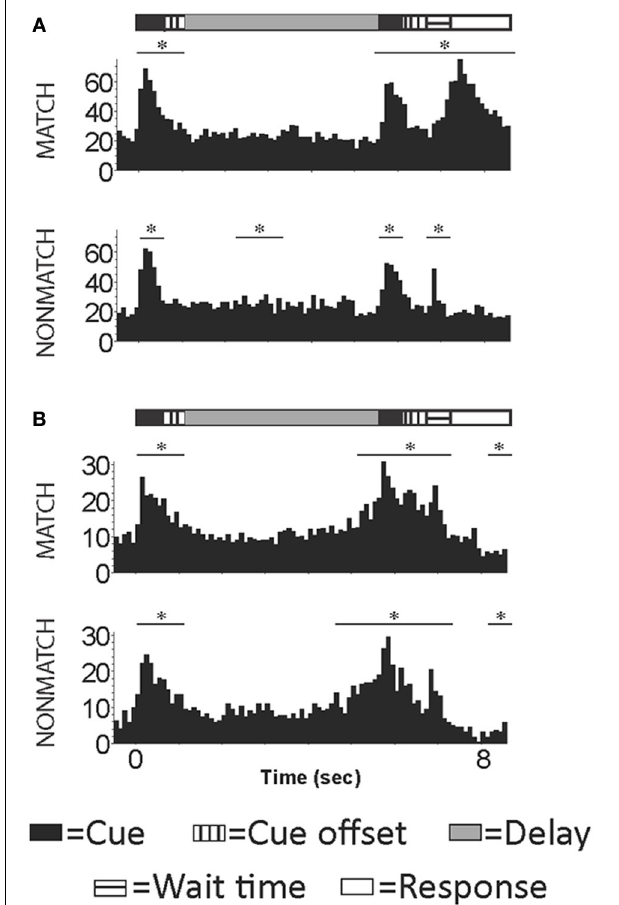
FIGURE 5 | Example cells with activity occurring during the presentation of the auditory sample, match/nonmatch and during the decision period of an auditory delayed match-to-sample task. (A) An example cell with increased activity during the auditory cues, wait time and response periods for correct trials. (B) An example cell with increased firing rated during auditory cue and wait time periods for correct trials. Y-axis label is frequency (imp/s); bin = 100ms; asterisk signifies significant change in firing rate from